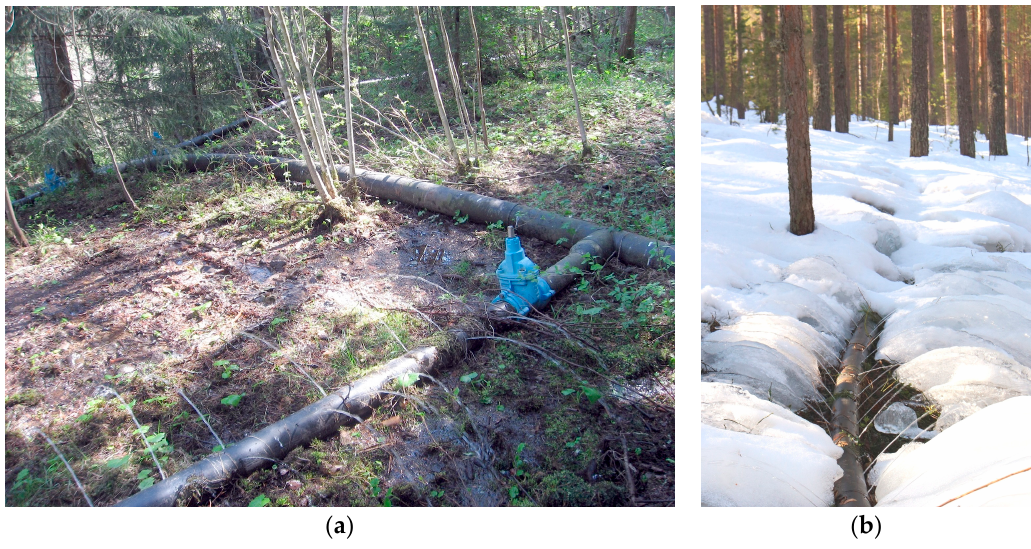
Figure 3. Sprinkling infiltration at ( a ) Ahvenisto MAR plant in May (Photographer, M. Mäkinen) and ( b ) Vuontee MAR plant in March (Photographer, J. Tyrväinen).